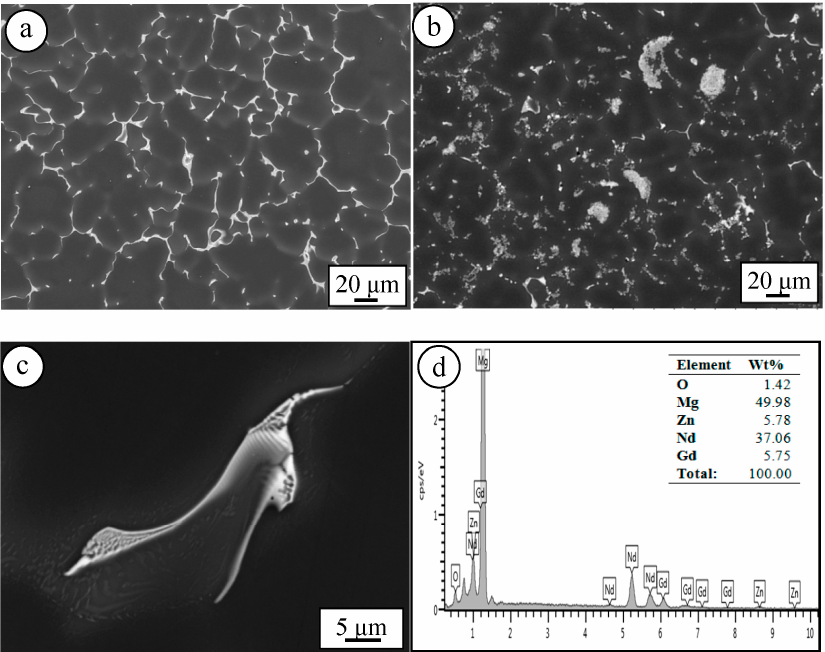
Figure 1. Microstructure of as-cast ( a ) El21; ( b ) El21-2%AlN; ( c , d ) El21 and its corresponding EDS.